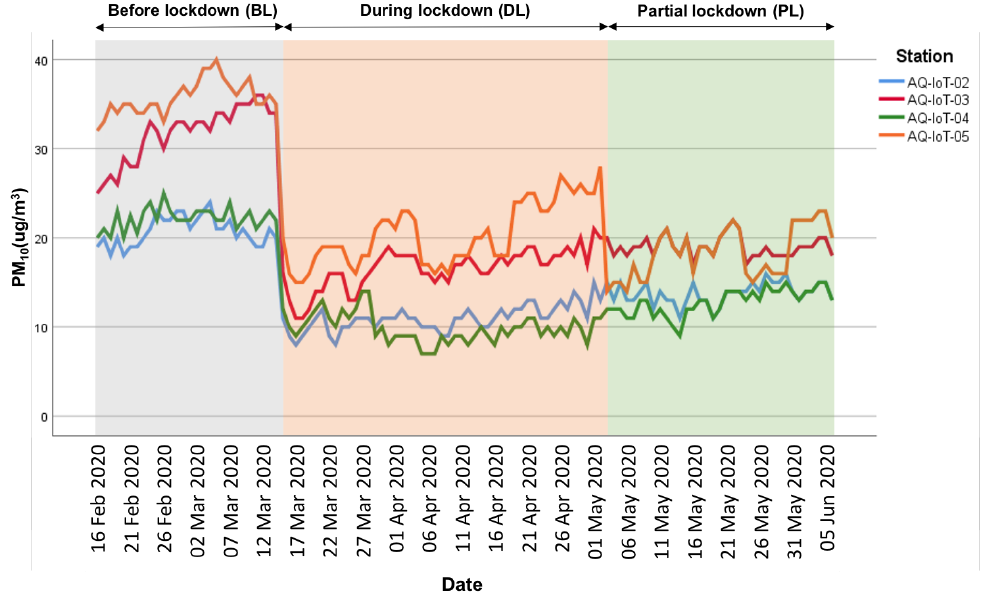
Figure 2. Daily (24 h) average concentrations of PM 10 between February 16 and June 05 in Victoria, Mexico (in highlighted sections, the different periods are indicated).